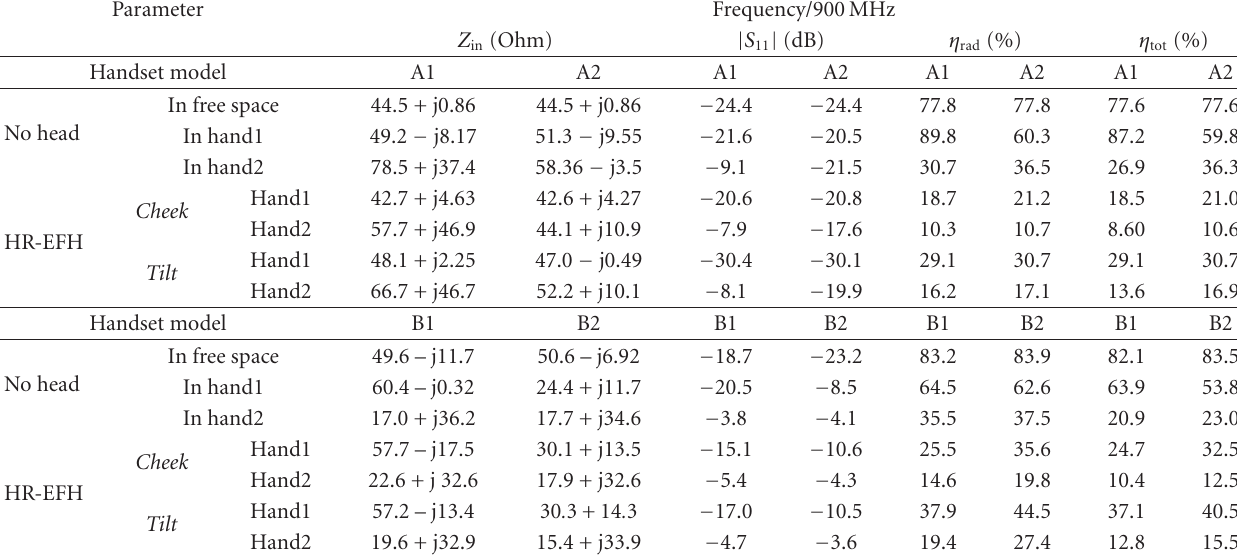
Table 4: Computational results of the antenna input impedance, Z in , | S 11 | in dB, radiation e ffi ciency, η rad , and total e ffi ciency, η tot , for di ff erent handset setups at 900